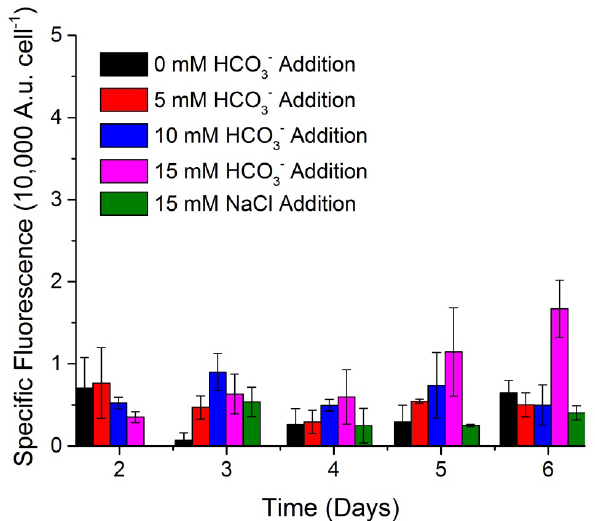
Figure 4. Mean and standard deviation of Scenedesmus sp. WC-1 specific Nile Red fluorescence in cultures which were sparged with 5% CO ( v / v ) in air and switched to 2 ambient air, at which time they were amended with 0, 5, 10, and 15 mM sodium bicarbonate, along with 15 mM sodium chloride as a control amendment. The gas sparge was changed and salt amendments were added at 3 days. Growth was maintained